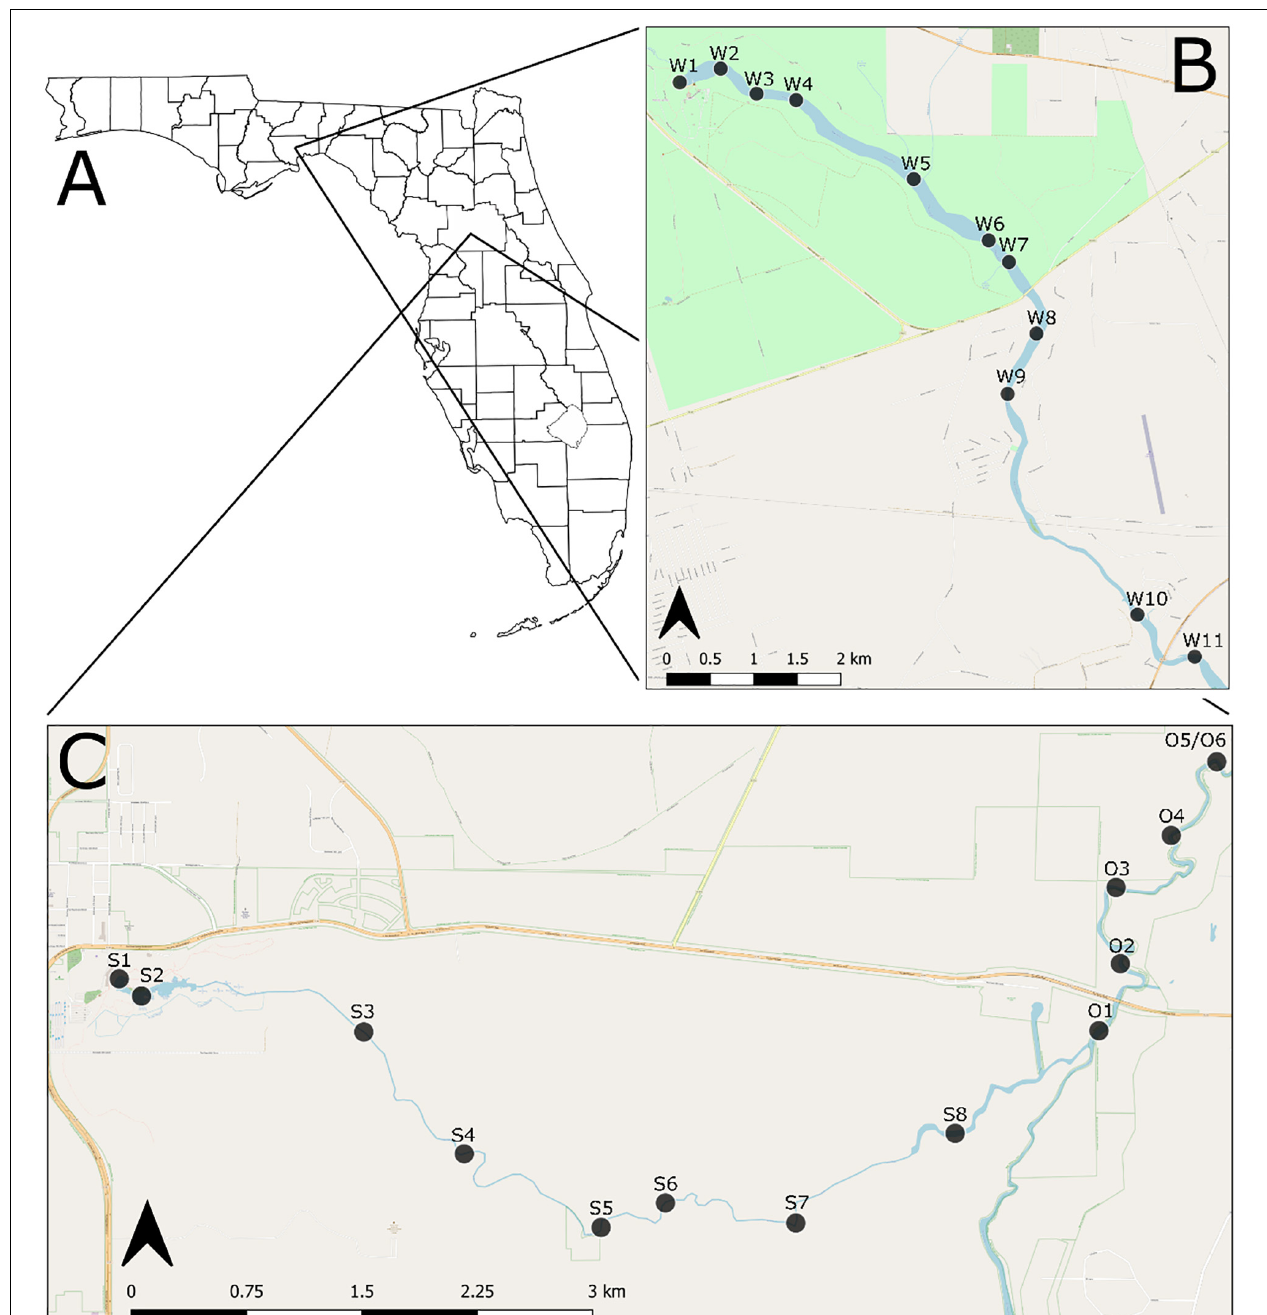
FIGURE 1 | (A) General location of the study area; (B) sampling sites along the Wakulla River; (C) sampling sites along the Silver and Ocklawaha Rivers. Sites along the Wakulla River begin with a “W,” along the Silver River begin with an “S,” and along the Ocklawaha River begin with an